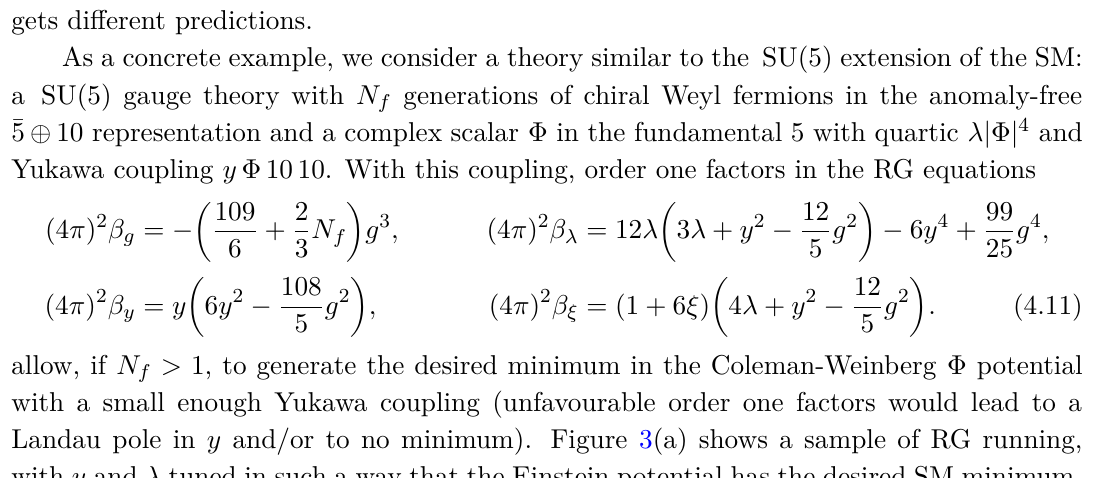
Figure 3 . Inflation with couplings that become non-perturbative in the IR giving rise to confine- ment. Left : sample of RG running in the model of section 4.3 with N g = 1 at the SM minimum after inflation. Right : its inflationary predictions for different values of g